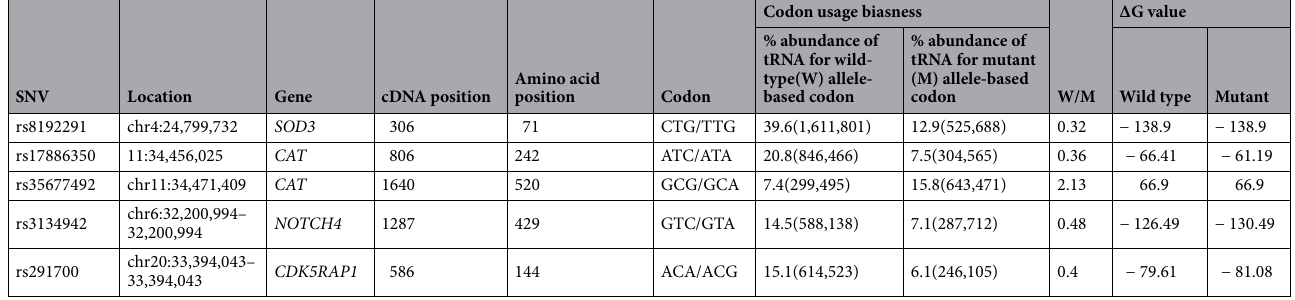
Table 2. List of the prioritized vitiligo associated synonymous